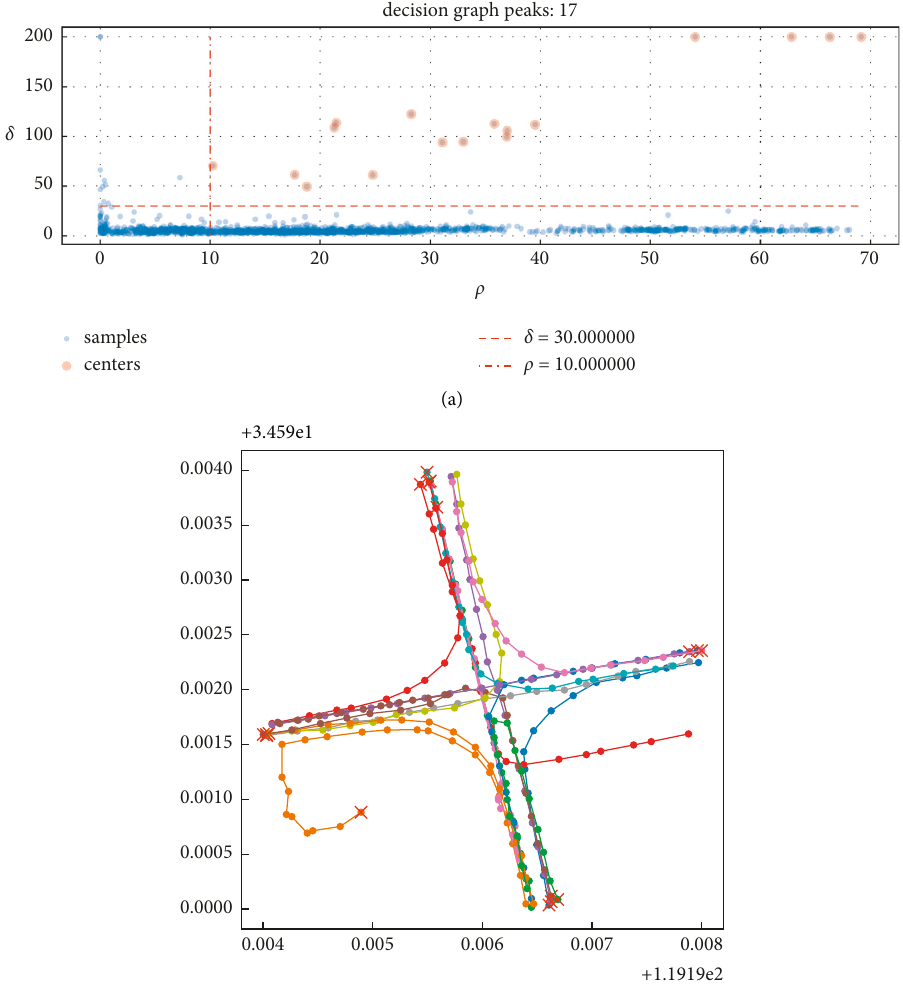
Figure 10: Decision graph and cluster center trajectories. (a) Decision graph. (b) Cluster center